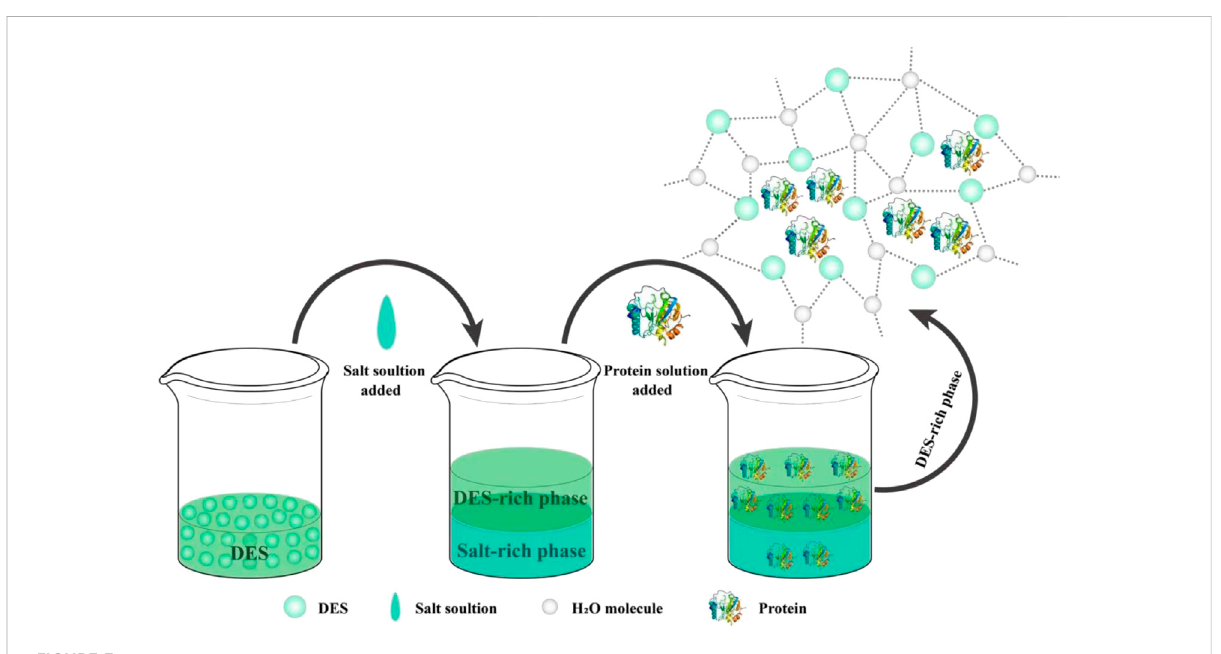
FIGURE 3 Application of DES-based ATPS for protein extraction and puri fi